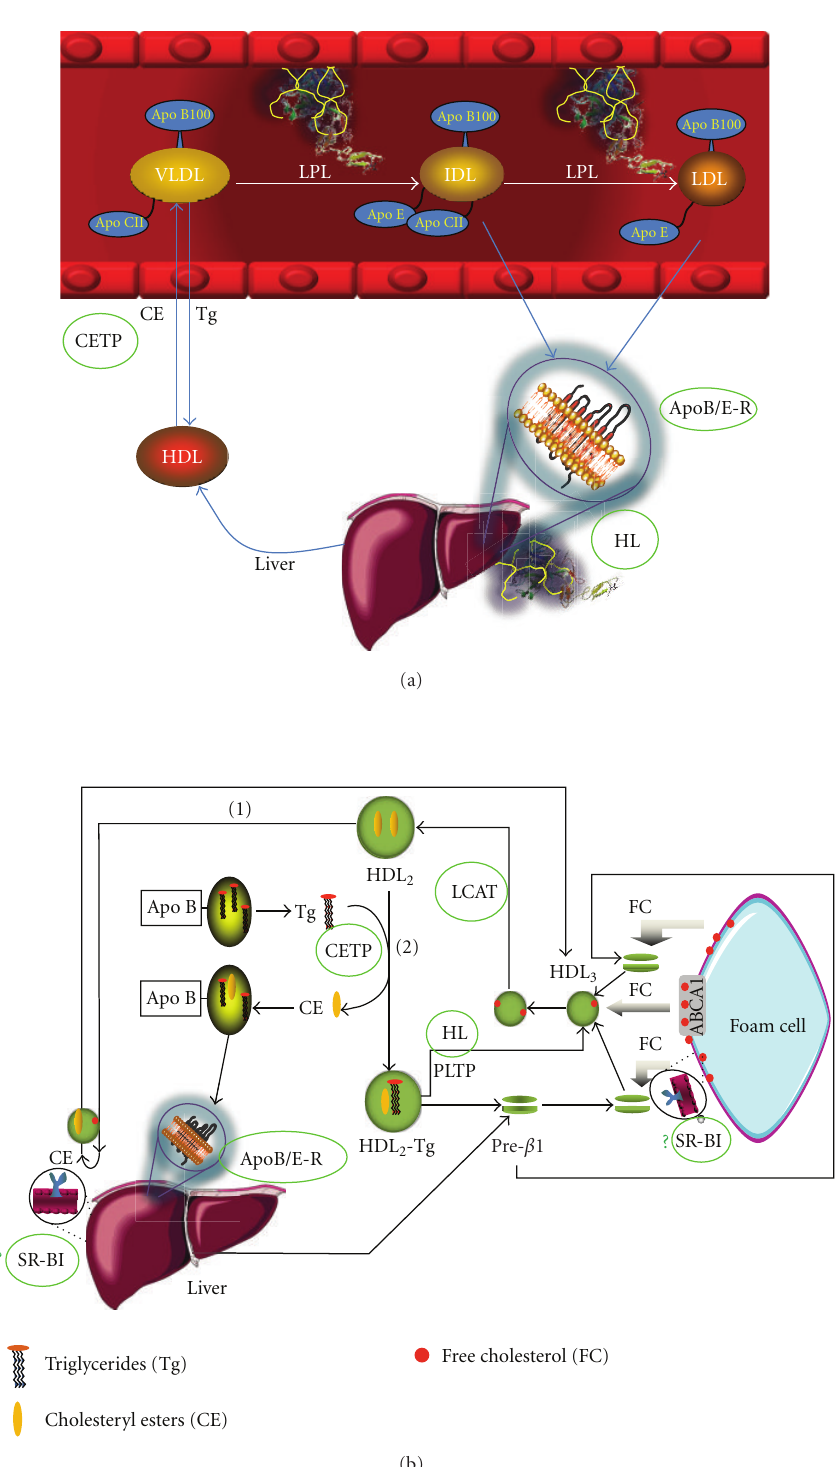
Figure 9: Intravascular metabolism of lipoproteins. (a) Very low-density lipoproteins (VLDLs) synthesized by the liver follow a lipolstic cascade up to the formation of low-density lipoproteins (LDLs), which are cleared from plasma by the apo B/apo E hepatic receptor (apoB/E- R). The cholesteryl esters transfer protein (CETP) facilitates the exchange of triglycerides from apo B containing lipoproteins to HDL and cholesteryl esters in the opposite sense. (b) High-density lipoproteins (HDL) pick up cholesterol from peripheral tissues, including the foam cells. HDL cholesterol becomes esterified by the activity of the lecithin:cholesterol acyl transferase (LCAT). Cholesteryl esters are cleared from plasma by the hepatic scavenger receptor class B, type I (SR-BI) or via CETP. Proteins involved in lipid metabolism that are regulated by thyroid hormones have been highlighted with green circles; low expression levels of SR-BI have not been reported (indicated by a green question